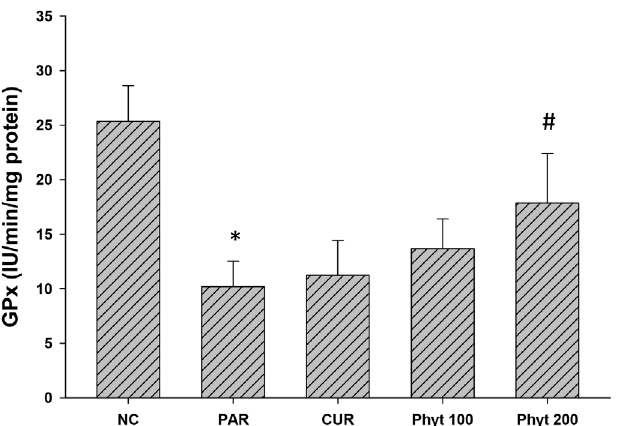
FIGURE 11 - Effect of phytosome curcumin on GPx activity of control and treated animals in paracetamol-induced liver injury in mice. Value represents as mean ± S.D. * p<0.05, significant difference compared with control group, # p<0.05, significant difference compared with paracetamol group ( n =